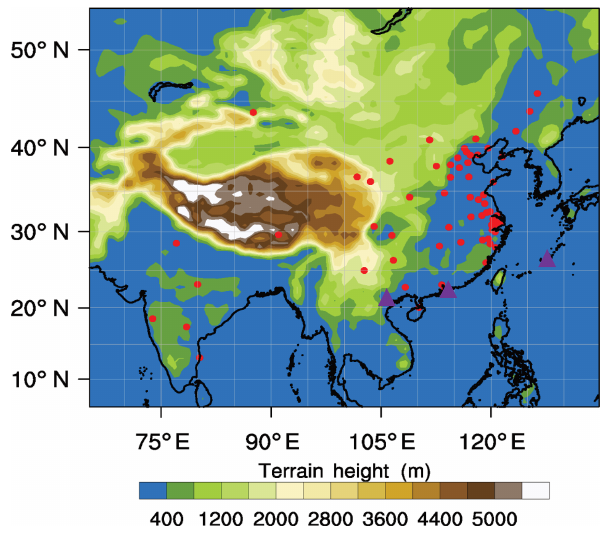
Figure 1. WRF-Chem domain setting with terrain height and the locations of surface ozone observations marked by solid red cir- cles. Solid purple triangles mark the location of ozonesonde obser-